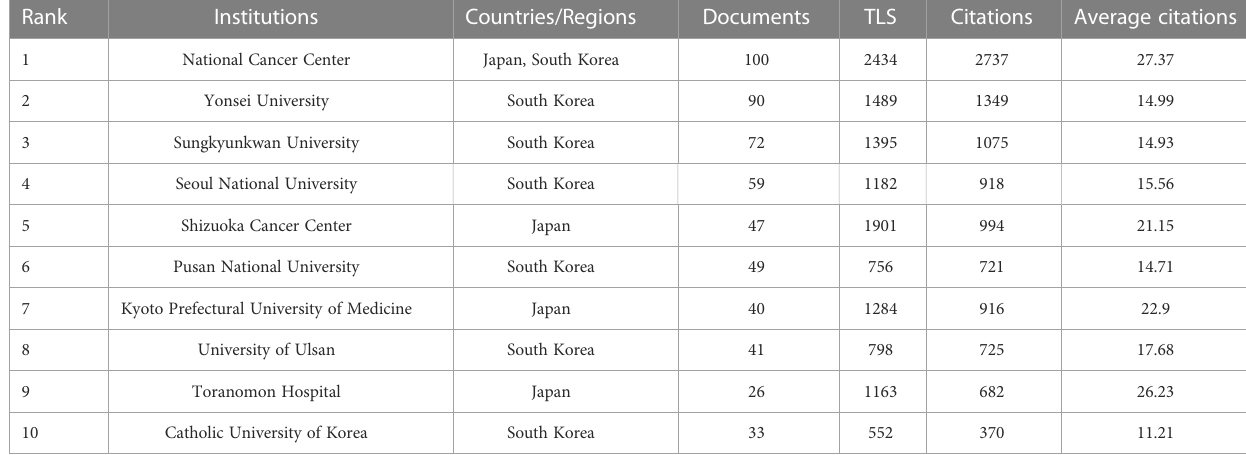
TABLE 3 Top 10 institutes in the publications related to endoscopic application in early gastric